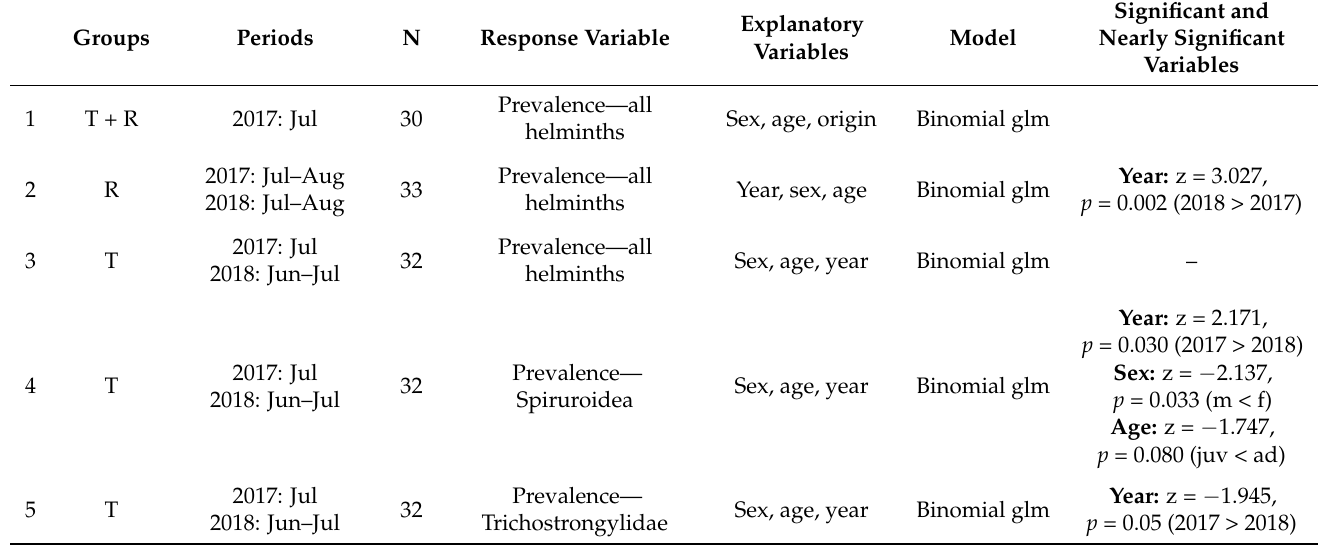
Table 3. Parameters of the statistical analyses applied with prevalence as a response variable. Glm— generalized linear model; T—translocated;